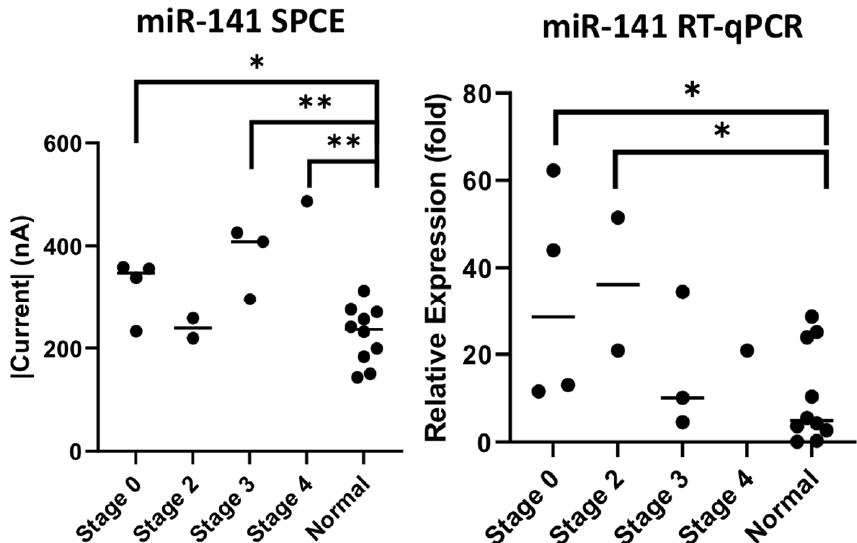
Figure 10. Measurement of miR-141 by cancer staging through miR-141 SPCE and RT-qPCR. * p -value < 0.05, ** p -value < 0.005.